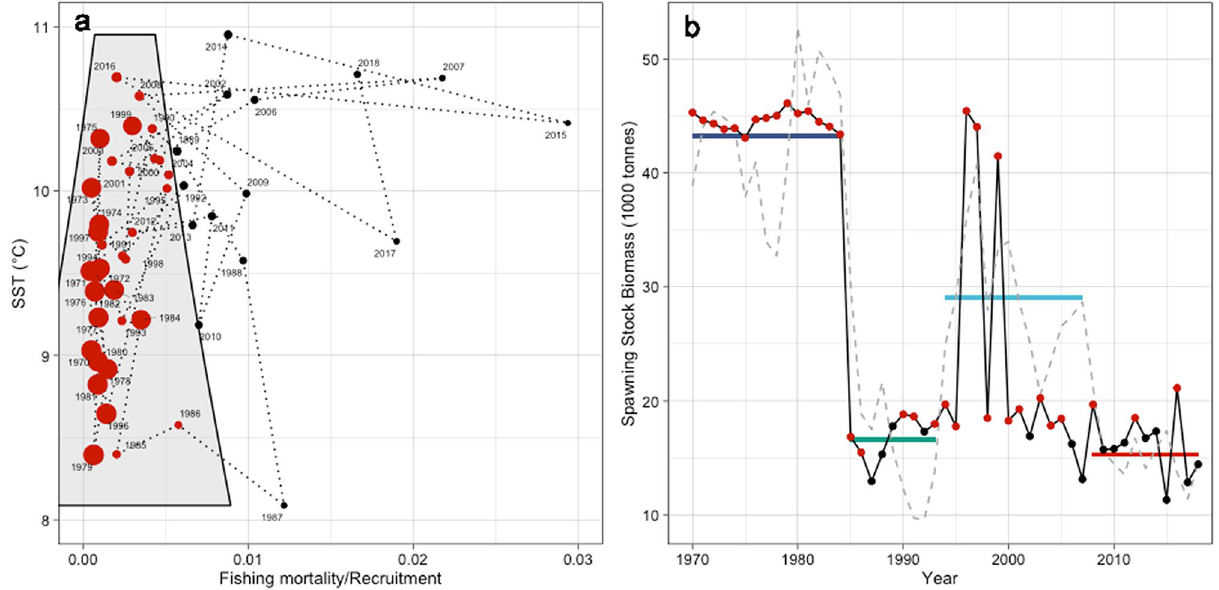
Figure 4. Hysteresis and stable states in Western Baltic cod. ( a ) Effect of scaled exploitation pressure, i.e. fishing mortality (F) relative to recruitment (R, i.e. year-class strength at age 1), and sea surface temperature (SST) on spawning stock biomass (SSB; points scaled to predictions from stochastic cusp modelling); grey shaded polygon indicates the cusp area where bistability of the system exists. ( b ) Time-series on observed (grey dashed line) and predicted SSB (points and black solid line) from stochastic cusp modelling; horizontal coloured bars indicate SSB regimes (see Fig. 1). In ( a ) and ( b ) red points indicate the system to be in the bistable cusp area (see polygon in a ) and black points indicate a stable system, outside the cusp